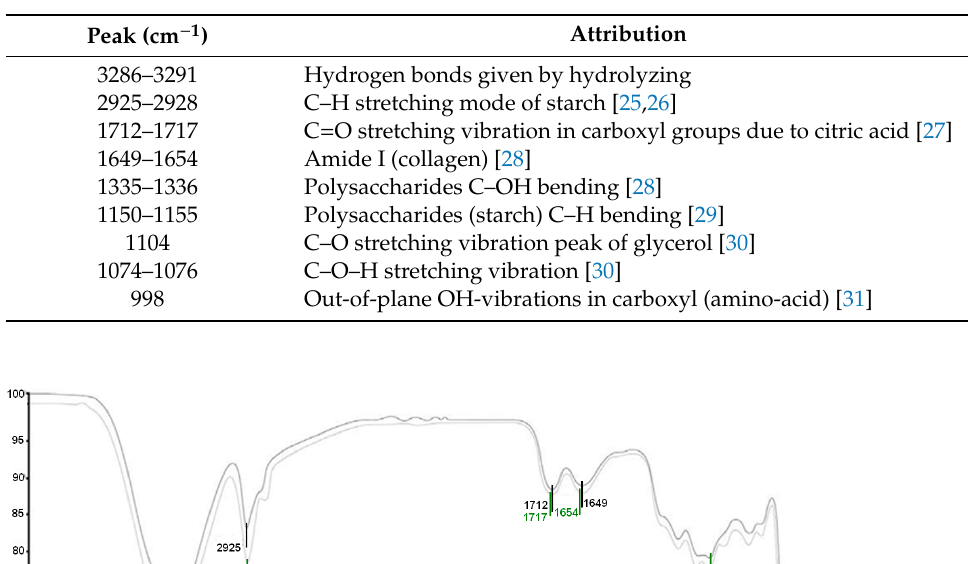
Table 3. Attribution of FTIR peaks observed during the scanning.